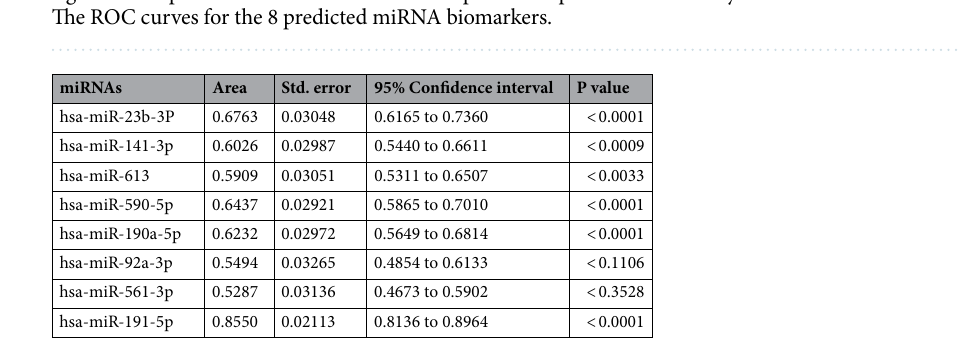
Table 2. The result of AUC analysis for the 8 initially predicted miRNA biomarkers.